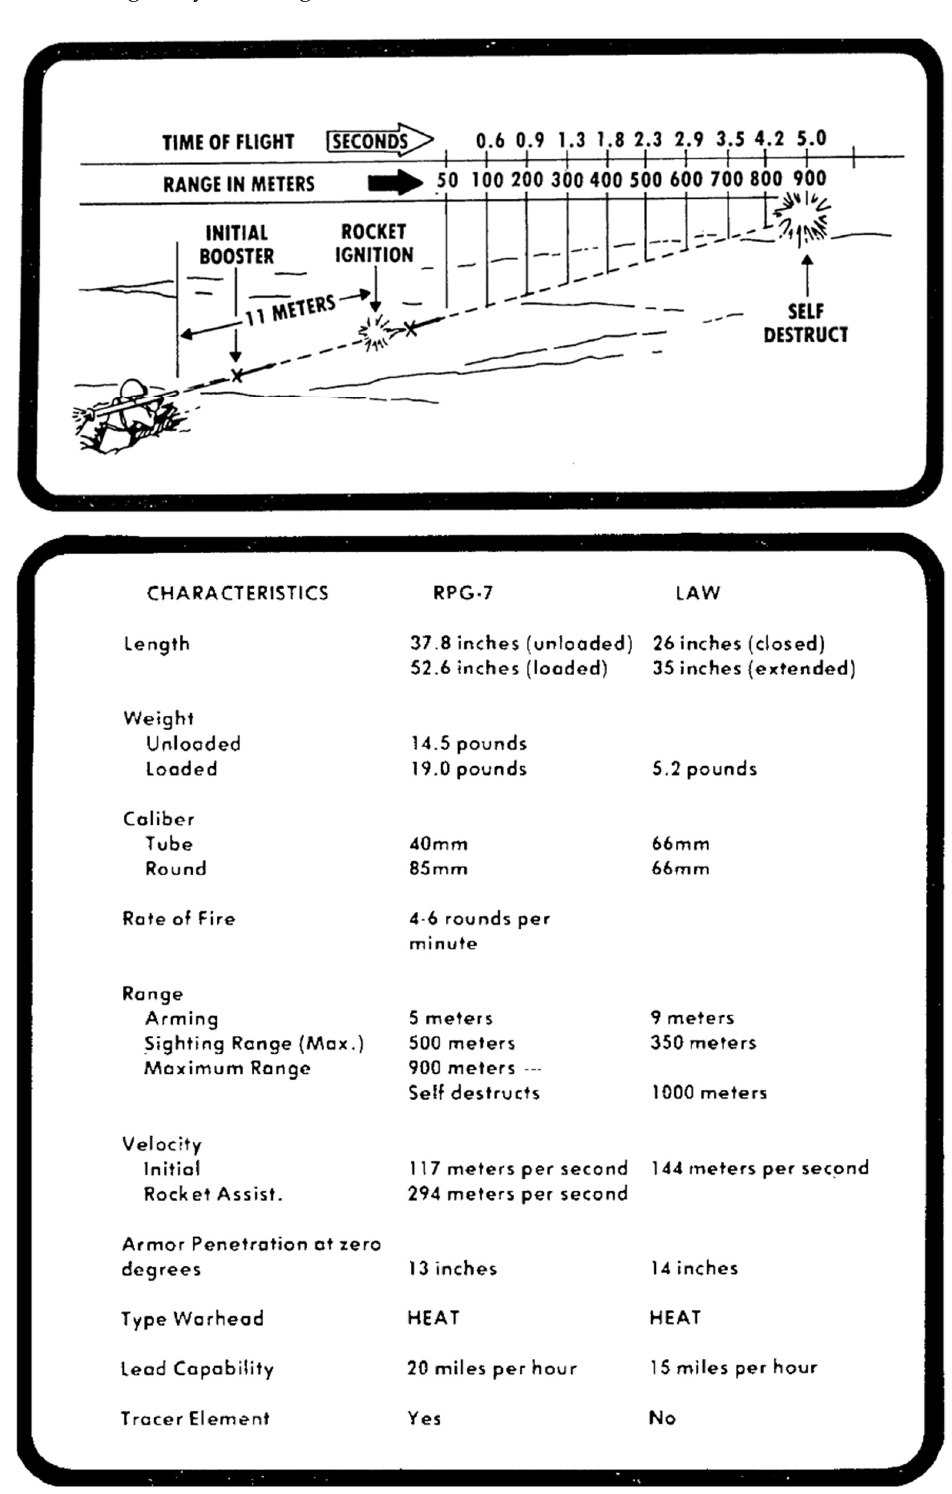
Figure 25. Available open-source data regarding the trajectory and projectile flight characteristics of the PG-7 projectile reproduced from [4].